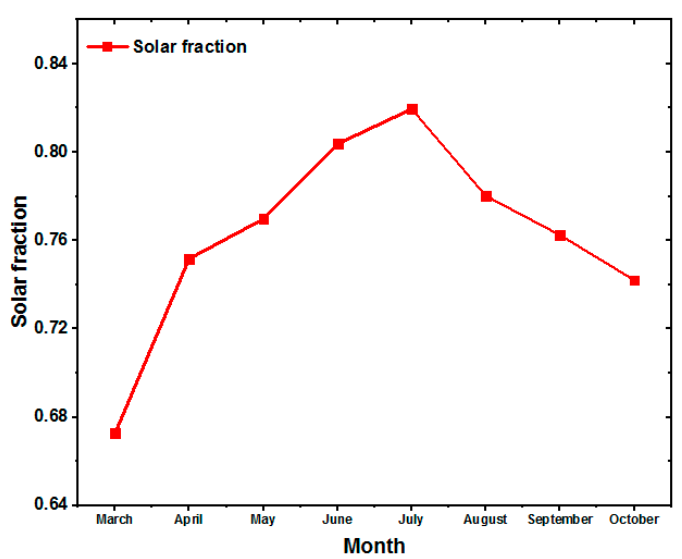
Figure 5. Solar fraction ( SF ) of solar-assisted hybrid SDCS.